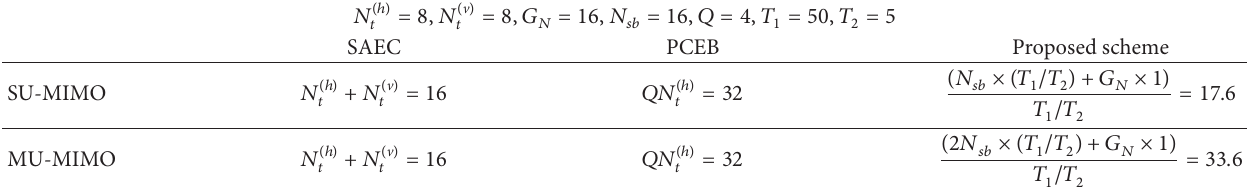
Table 2: The CSI-RS overhead comparison of different